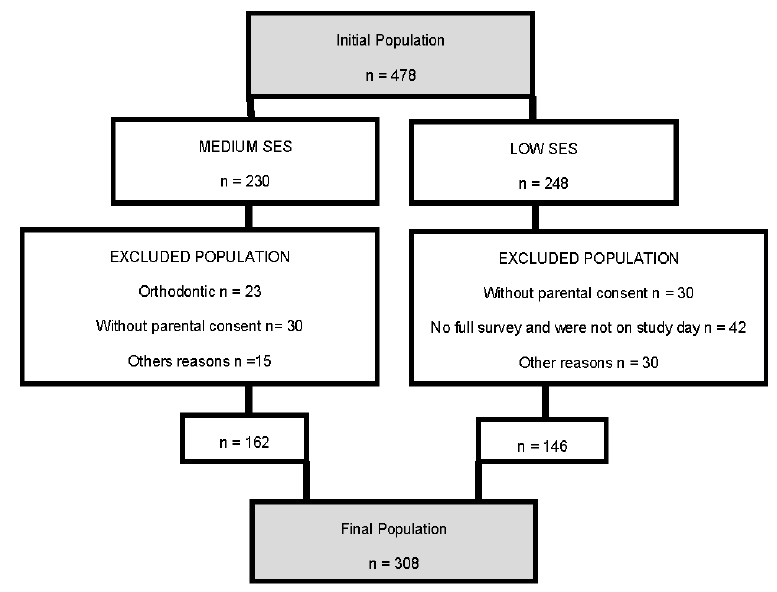
Figure 1. Information on the sample size in a flow diagram